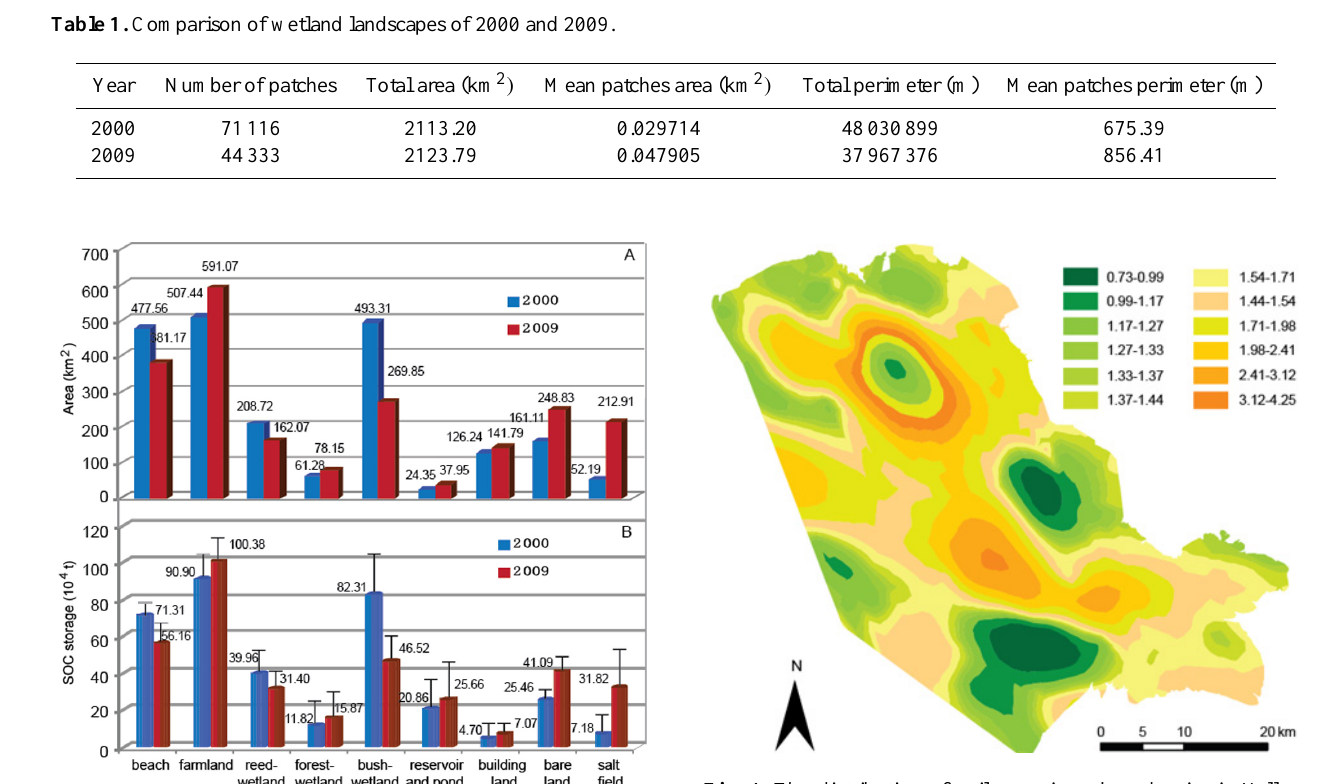
Fig. 4. The distribution of soil organic carbon density in Yellow River